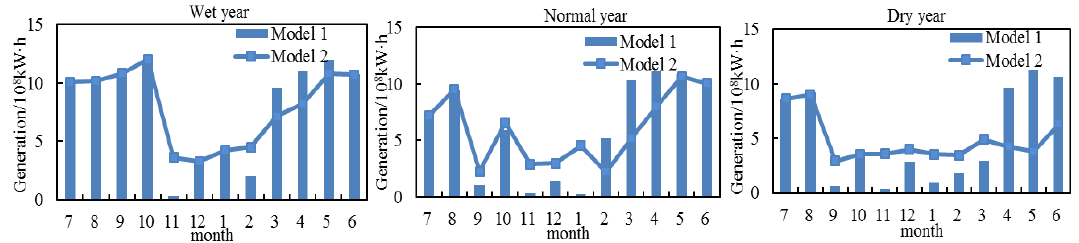
Figure 7. Variation of discharge from the Xiaolangdi reservoir in each typical year.